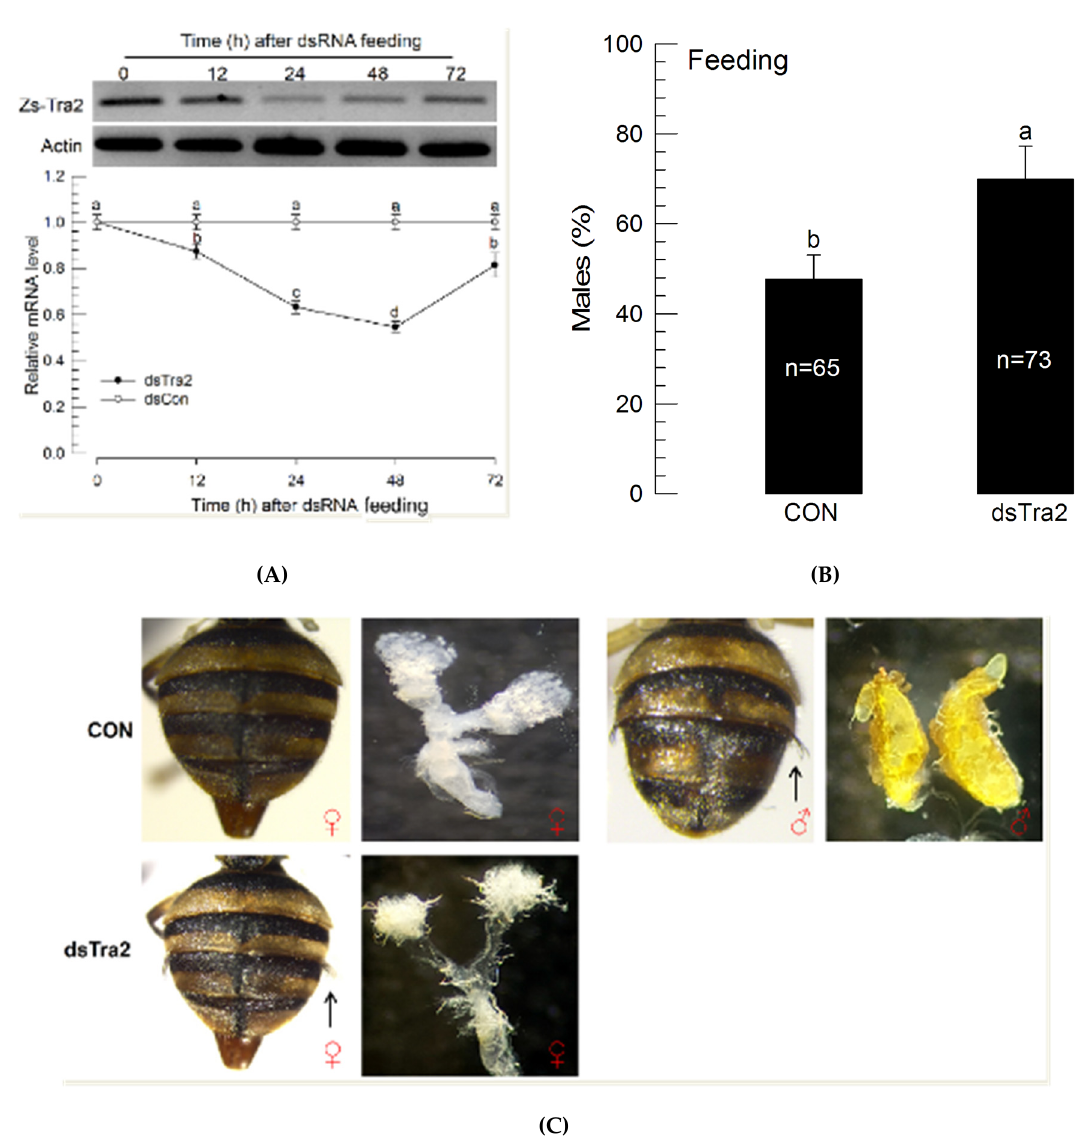
Figure 6. Influence of recombinant E. coli expressing dsRNA (‘dsTra2’) specific to Zs-Tra2 on male-biased adult production in Z. scutellata . RNAi was performed for newly molted L1 larvae ( < 12 h) by feeding diet (500 mg) containing recombinant E. coli , producing 25 µ g of dsTra2. Control (‘dsCON’) used non-recombinant bacteria. ( A ) RNAi e ffi ciency assessed by RT-qPCR. Actin was used as a reference gene of RT-qPCR to normalize target gene expression level. Each treatment was replicated with independently prepared samples. ( B ) Outcome assessed in ratio of male adults. Around 300~400 newly hatched L1 larvae were used for both control and treatment. Number indicates the number of assessed adults. Di ff erent letters above standard deviation bars indicate significant di ff erence among means at Type I error = 0.05 (LSD test). ( C ) Phenotypic analysis in abdominal structures including ovipositor for female character and abdominal pleural setae (see arrows) for male character.